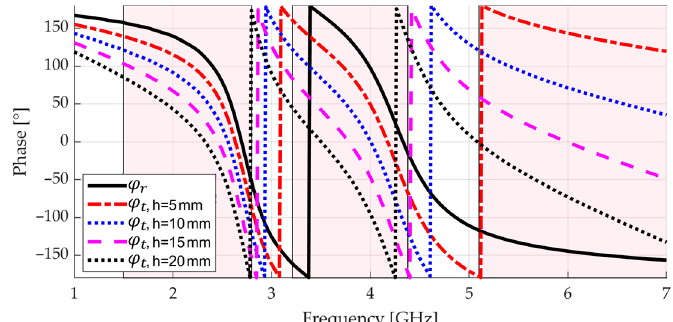
Figure 5. Reflection phase of the final unit cell in its own plane ( ϕ r ) and in the plane of an antenna spaced by a distance h ( ϕ t ). The highlighted areas show when | ϕ t | < 120 ◦ for h = 10 mm.